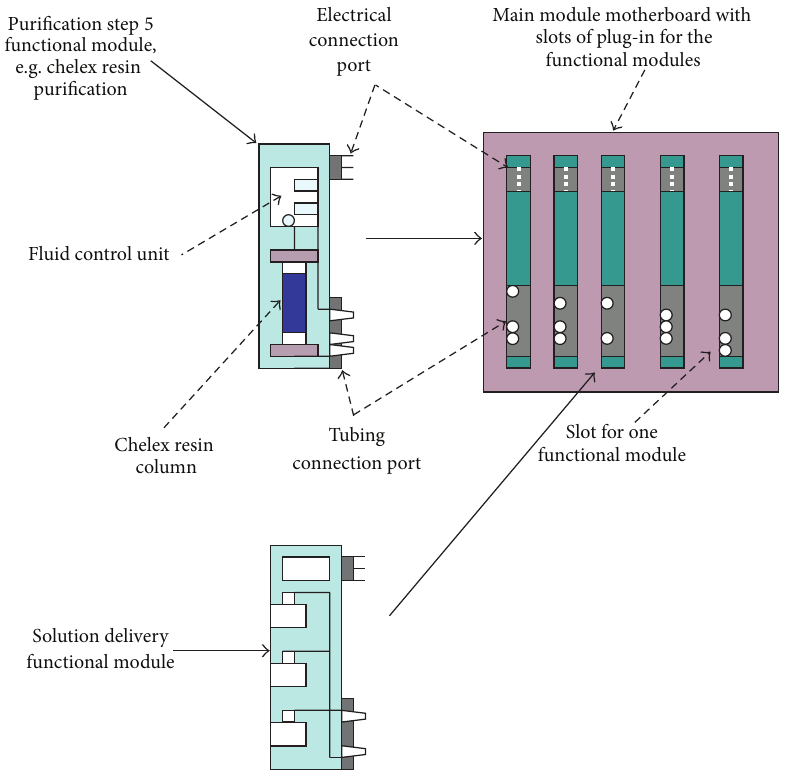
Figure 1: Conceptual diagram of the modular technology of fission- 99 Mo recovery